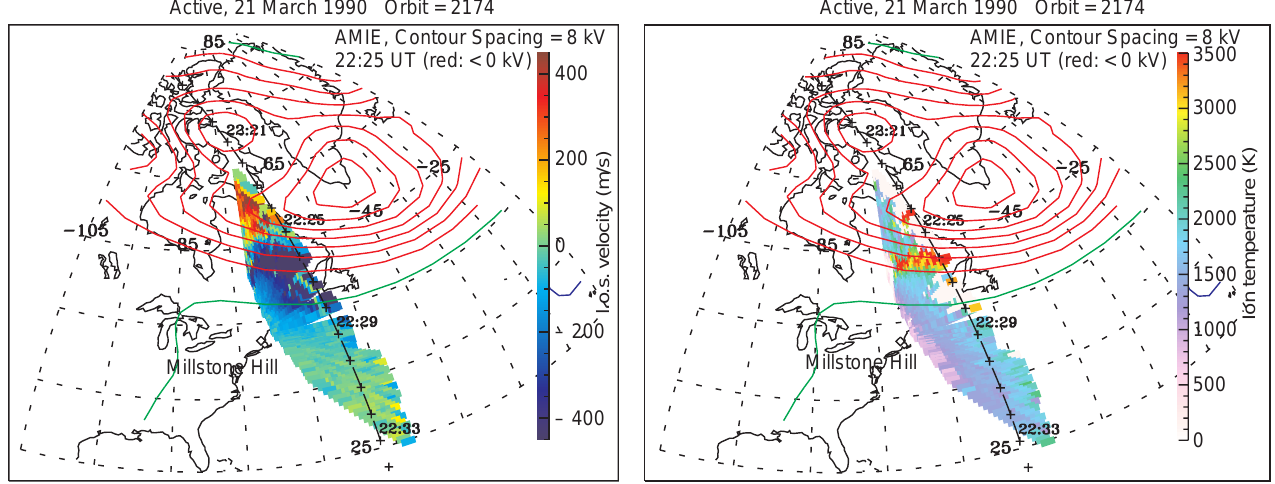
Fig. 11. Line-of-sight drift a and ion temperature measurements b of the azimuth-elevation scan of the Millstone Hill radar compared with the AMIE electric field potential pattern for the time moment 22:25 UT. The spacing of the potential contours is 8 kV with the green line as the zero level and the red lines for negative